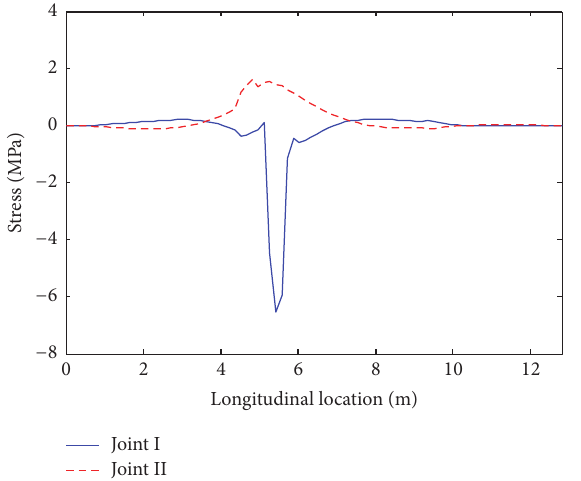
Figure 7: Stress influence lines of the welded joints.